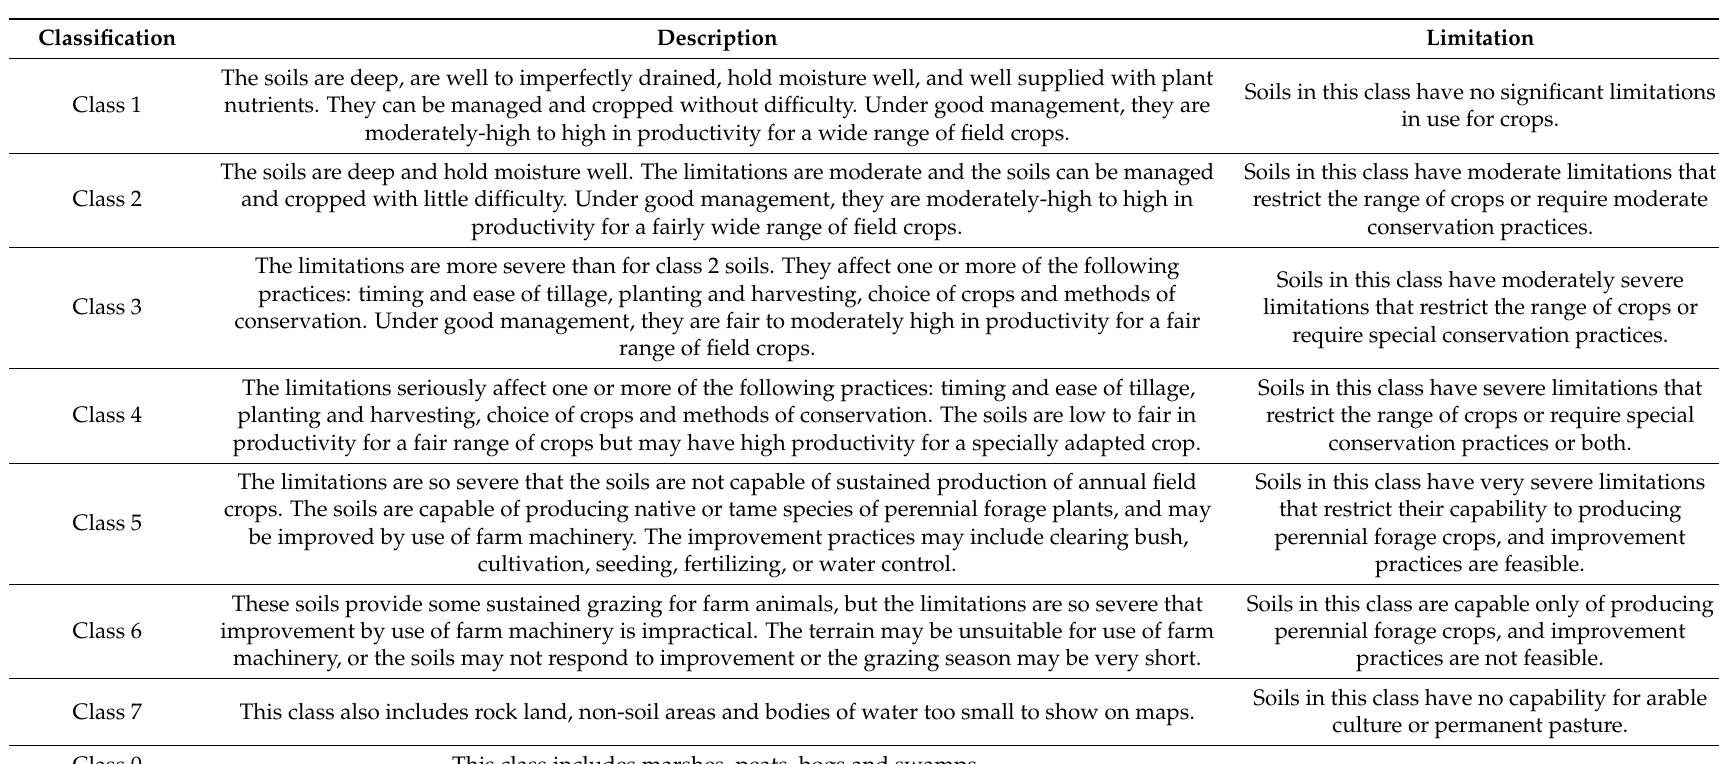
Table A2. Land classes in Canada and their characteristics